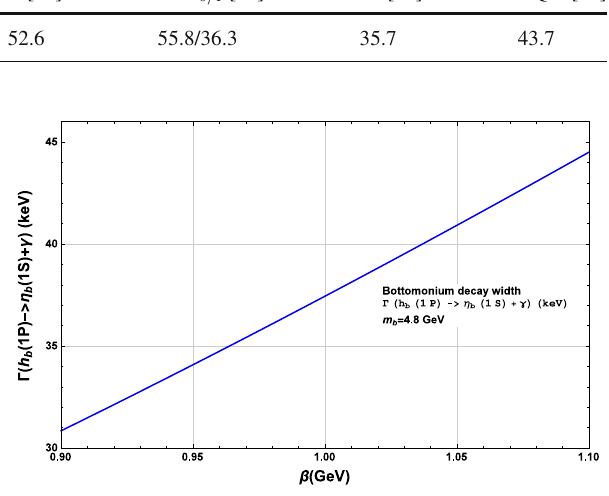
Fig. 4 Decay width for h b ( 1 P ) → η b ( 1 S ) + γ (keV) as a function of β h b ( 1 P )(η b ( 1 S )) in the LFQM, with m b